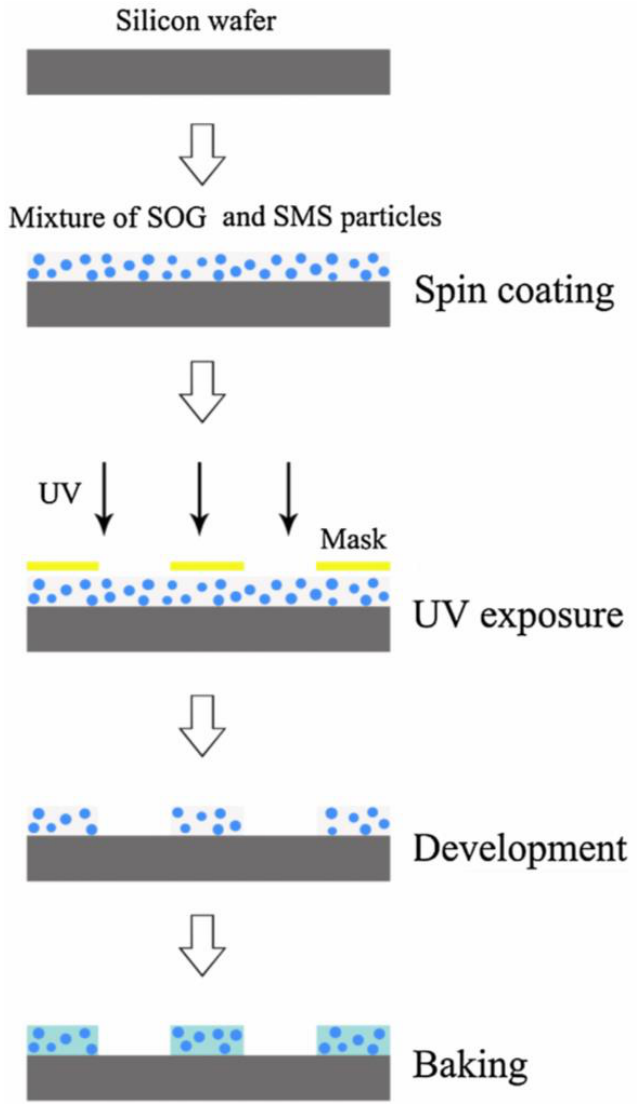
Figure 6. Schematic diagram of the experimental process used for SOG/SMS composite films. Adapted with permission from ref. [41]. Copyright 2016 Science Direct.